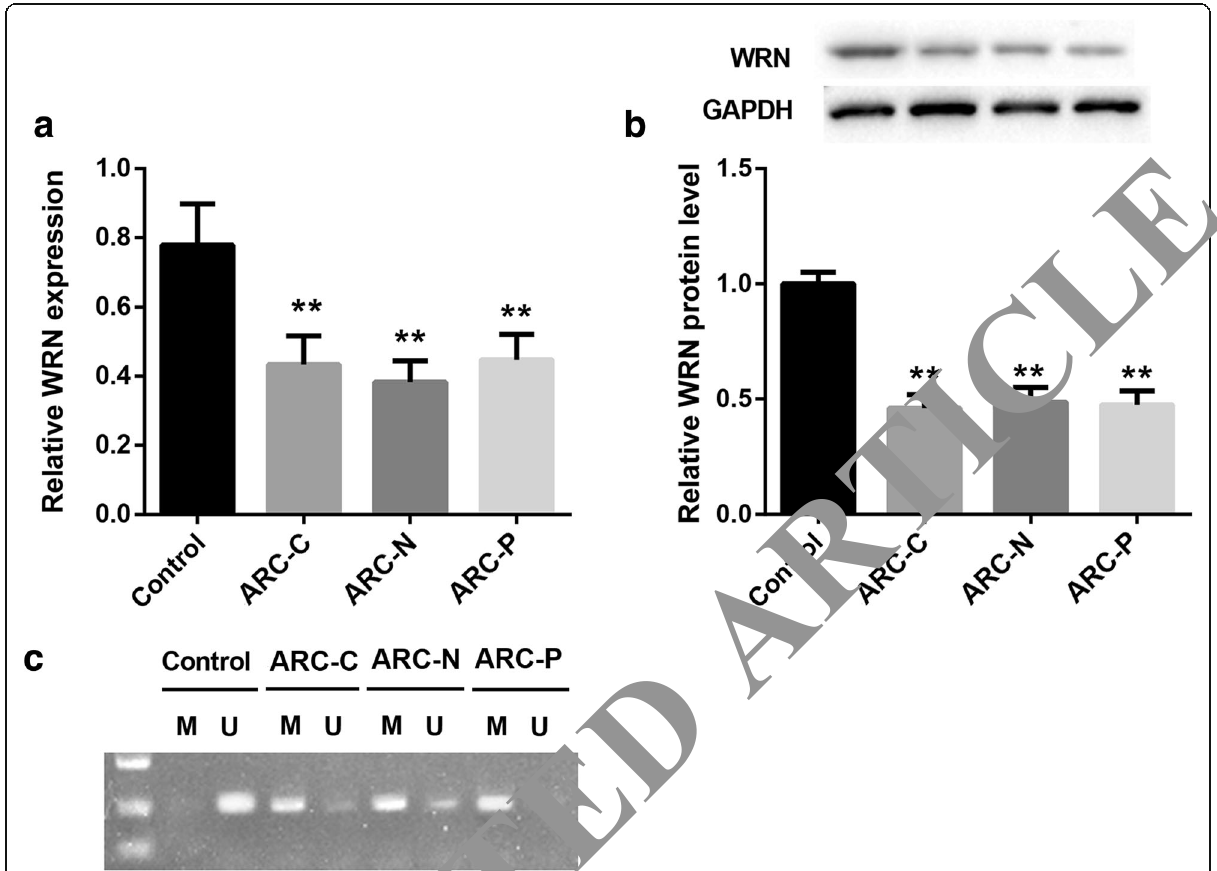
Fig. 1 The expression of WRN is decreased and the methylation level of WRN is increased in the anterior lens capsule tissues of patients with ARC. Anterior lens capsule tissues were obtained from the patients with different types of ARC (cortical, nuclear and posterior subcapsular cataract). The healthy anterior lens capsule tissues from age-matched person were as control. a QRT-PCR and b WB were performed to detect the gene and protein expression of WRN in the anterior lens capsule tissues. c MSP was performed to detect the methylation level of WRN in the anterior lens capsule tissues. M: methylation; U: unmethylation. ( ** P < 0.01 compared with the Control